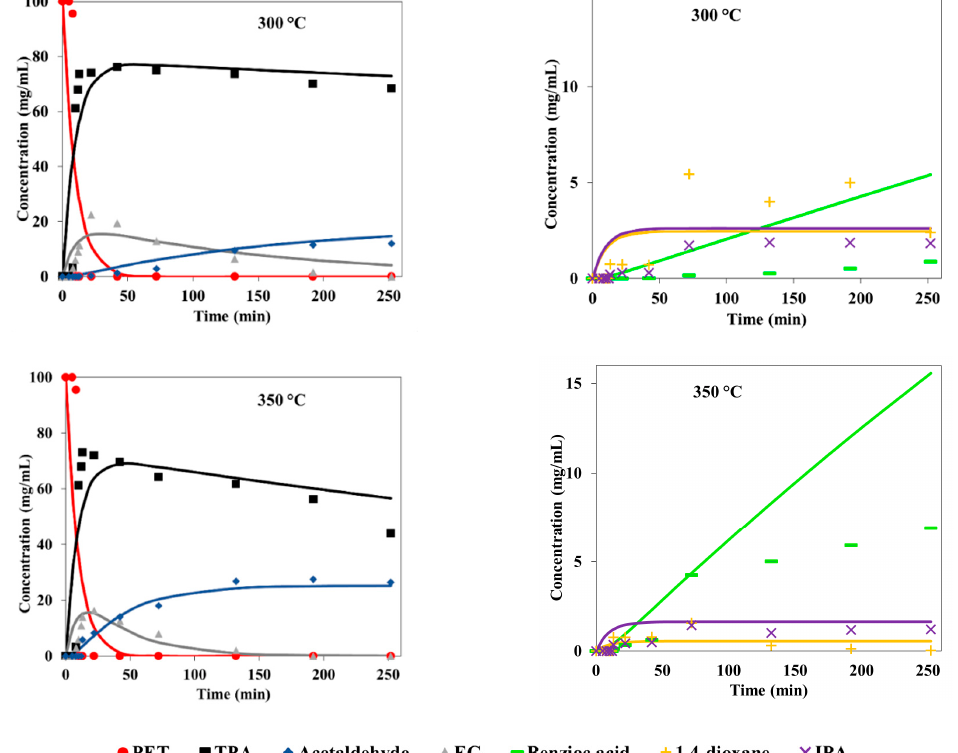
Figure 6. Colorless PET waste and its degradation products: TPA, EG, benzoic acid, 1,4-dioxane, acetaldehyde, and IPA at temperatures of 300 and 350 °C during heating period (first 12 min) and reaction at constant conditions. The symbols represent experimental measurements, while the curves represent a kinetic model.